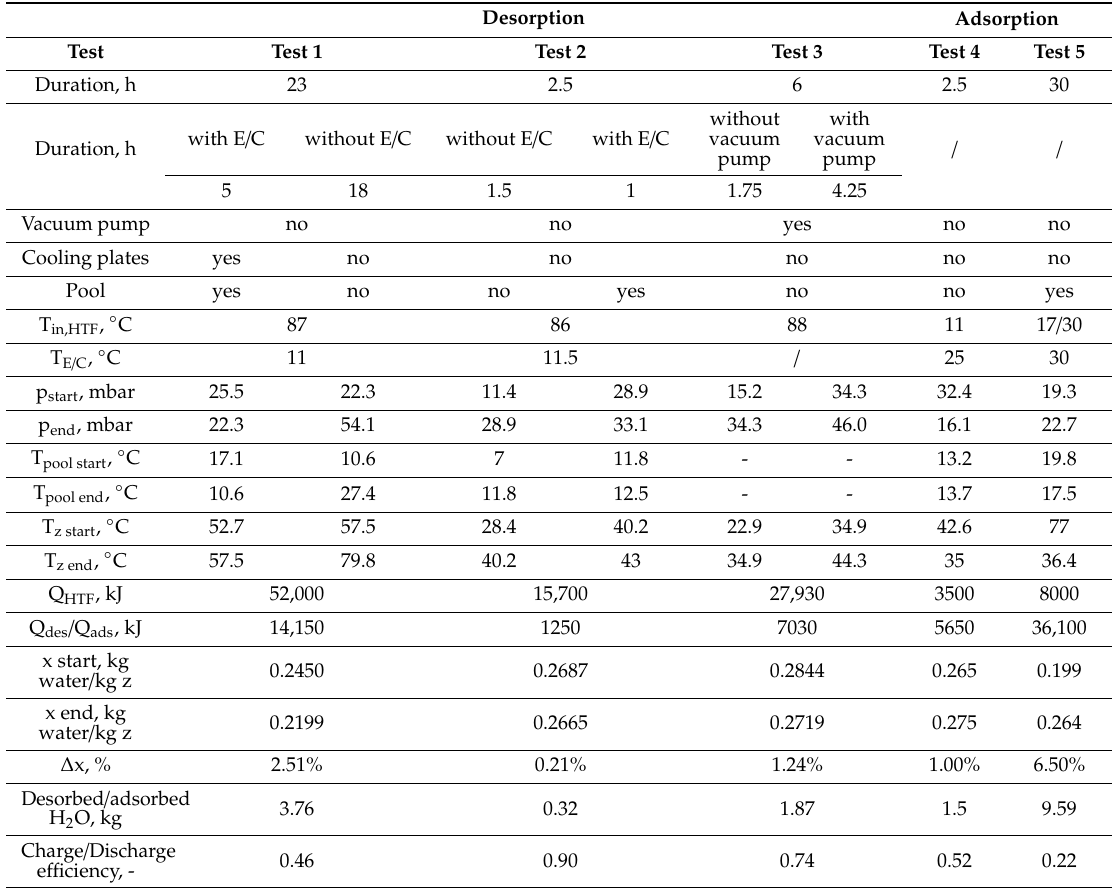
Table 1. Data and results of the experimental